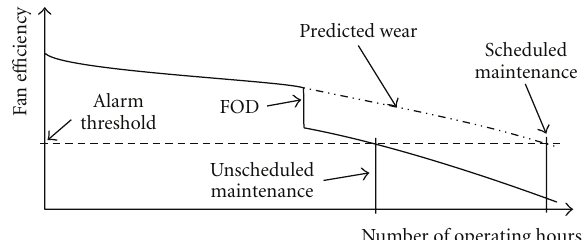
Figure 1: Typical fan e ffi ciency evolution showing gradual and abrupt